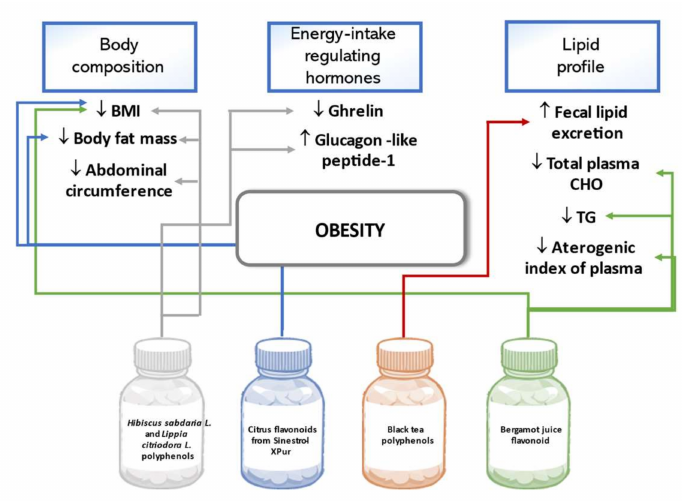
Figure 6. Effects of polyphenols on obesity in human